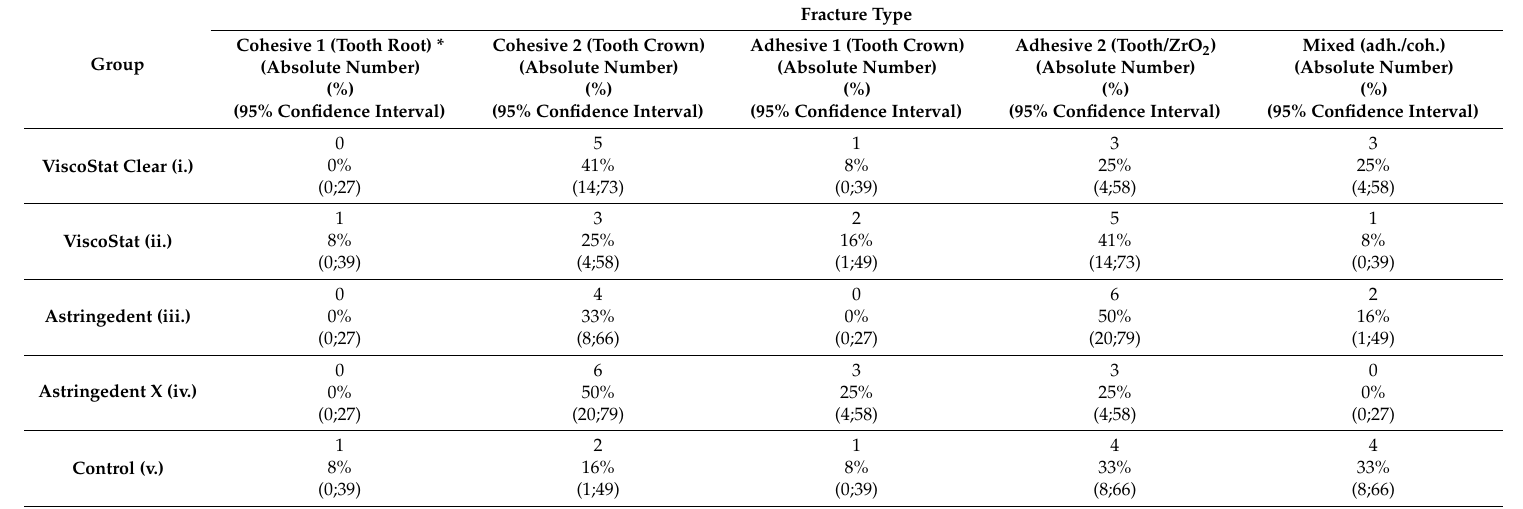
Table 4. Cross table showing fracture type distribution analyzed by Ciba-Geigy